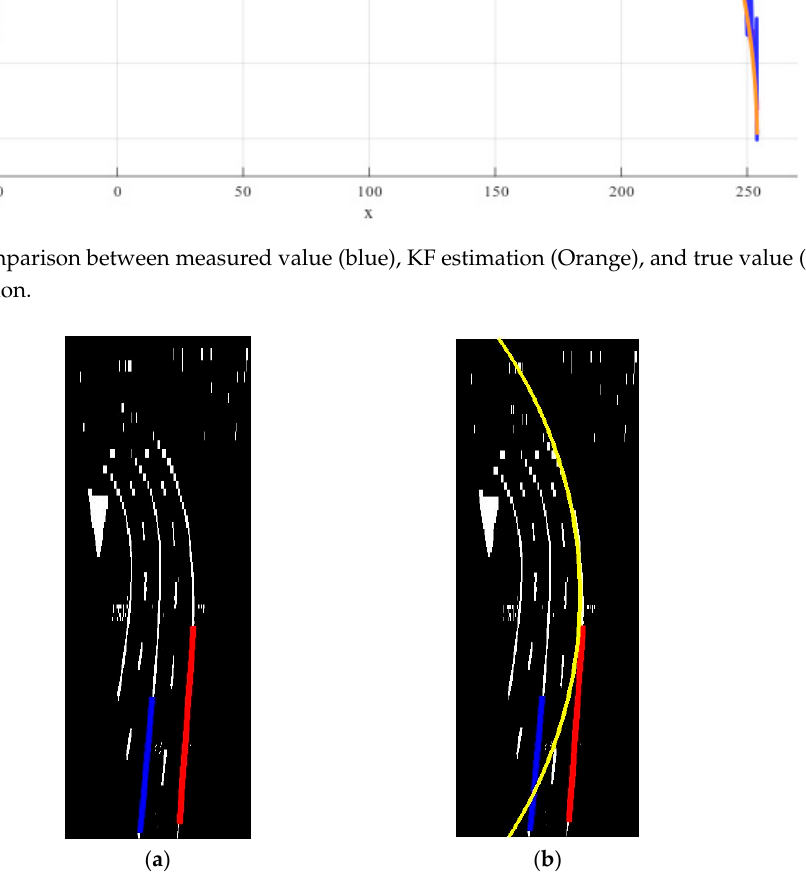
Figure 27. The result of curve lane detection based on circle model and Kalman filter (Yellow); ( a ) Input Image for Circle Detection, ( b ) Output Result